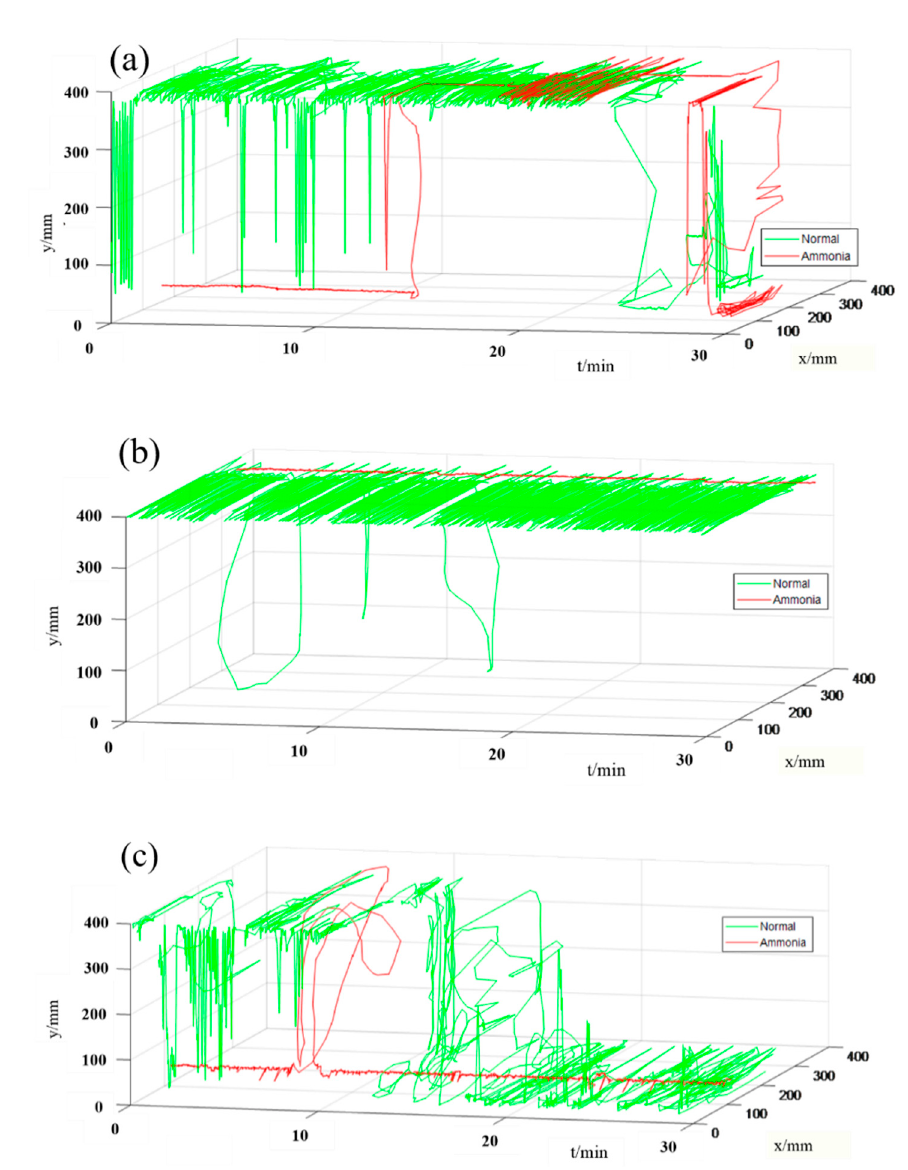
Figure 4. Trajectories of fish in three experiments. ( a ) Fish’s trajectory in the first experiment, ( b ) Fish’s trajectory in the second experiment, ( c ) Fish’s trajectory in the third experiment. The green curve represents the behavior trajectories of the fish in the normal environment, and the red curve represents the behavior trajectories of the fish in the different ammonia environment.